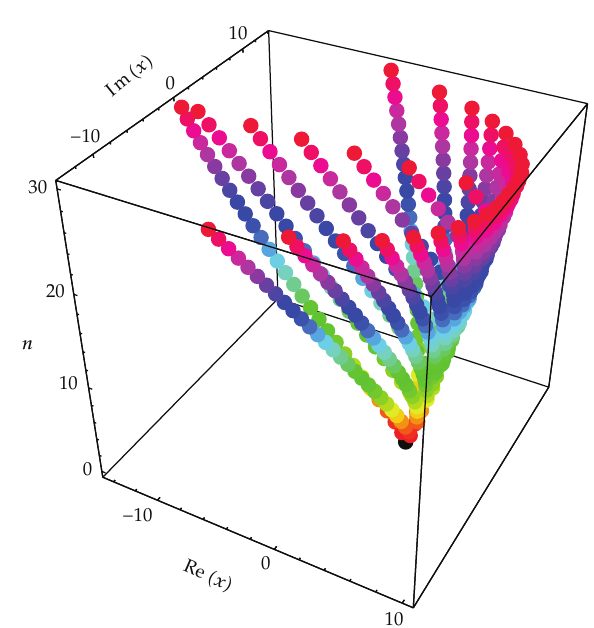
Figure 4: Stacks of zeros of E n,q,w (cid:2) x : a (cid:3) for 1 ≤ n ≤